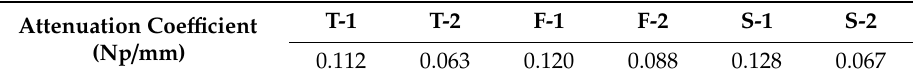
Table 1. Attenuation coe ffi cients at each point calculated from ultrasonic signals obtained by the scanning of each